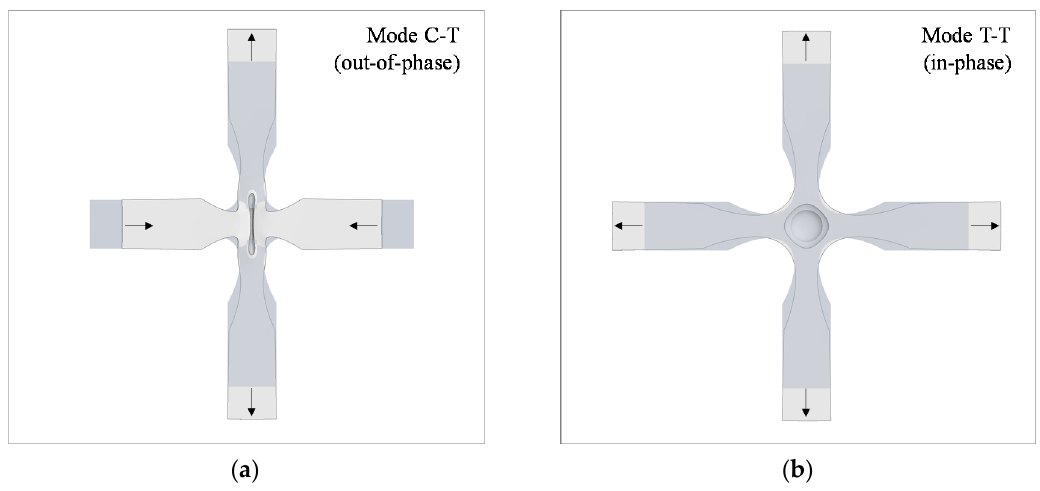
Figure 17. Cruciform test specimen axial (tension) mode shapes: ( a ) C-T (out-of-phase); ( b ) T-T (in-phase) (deformation was exaggerated for better understanding) [25].